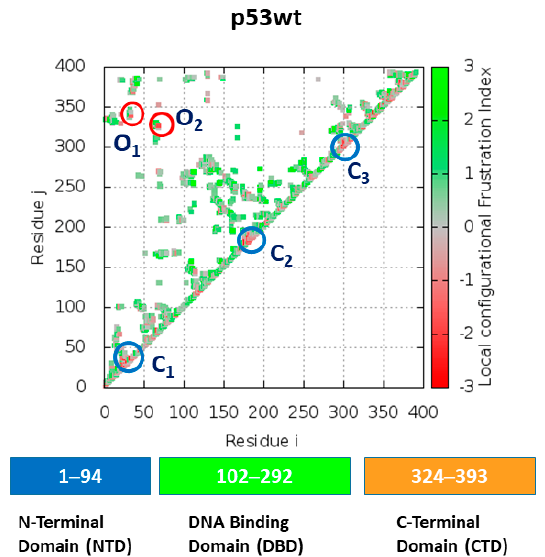
Figure 6. Frustration map of p53wt showing colored spots to indicate the level of frustration: green represents minimal frustration and red high frustration. The main clusters along the diagonal, corresponding to connections between residues close along the chain, are indicated by blue circles. The main clusters out of the diagonal, corresponding to connections between residues spatially close but belonging to different part of the molecule, are indicated by red circles.